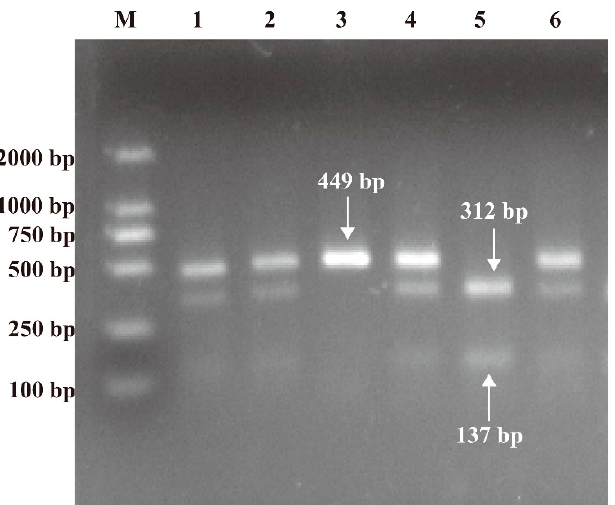
Figure 1. RFLP photograph of 2% agarose gel electrophoresis representing NAPRT V762A polymor- phism. Lane 3 was characterized by a single 449 bp representing wild genotype TT; lanes 1, 2, 4,